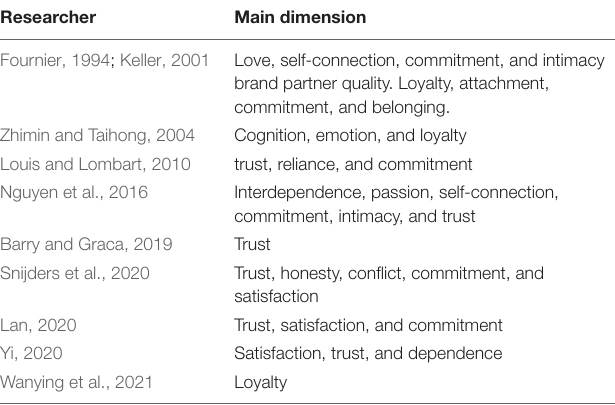
TABLE 1 | Dimensions of brand relationship quality.